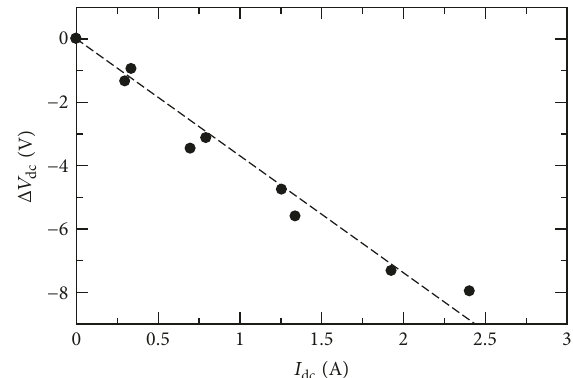
Figure 18: DC voltage drop across the inverter.